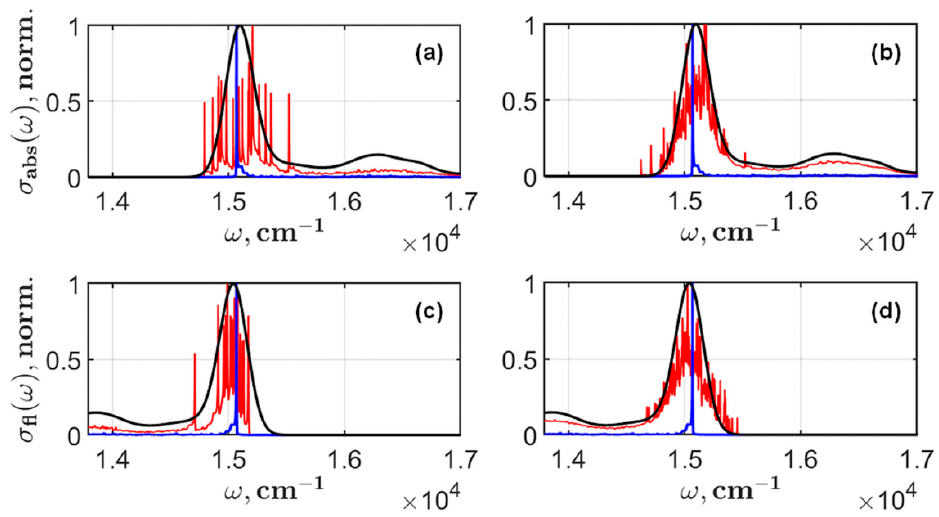
Figure 4. Calculated absorption ( a , b ) and steady-state fluorescence ( c , d ) of monomeric Chl in dimethyl ether are presented. The zero phonon line (blue) and the calculated (black) spectra according Equations (1) and (2) are shown for comparison with the spectra (red) obtained by using the Monte Carlo method for simulation of the inhomogeneous broadening effect. These spectra (red) were obtained after 20 ( a , c ) and 200 ( b , d ) Monte Carlo